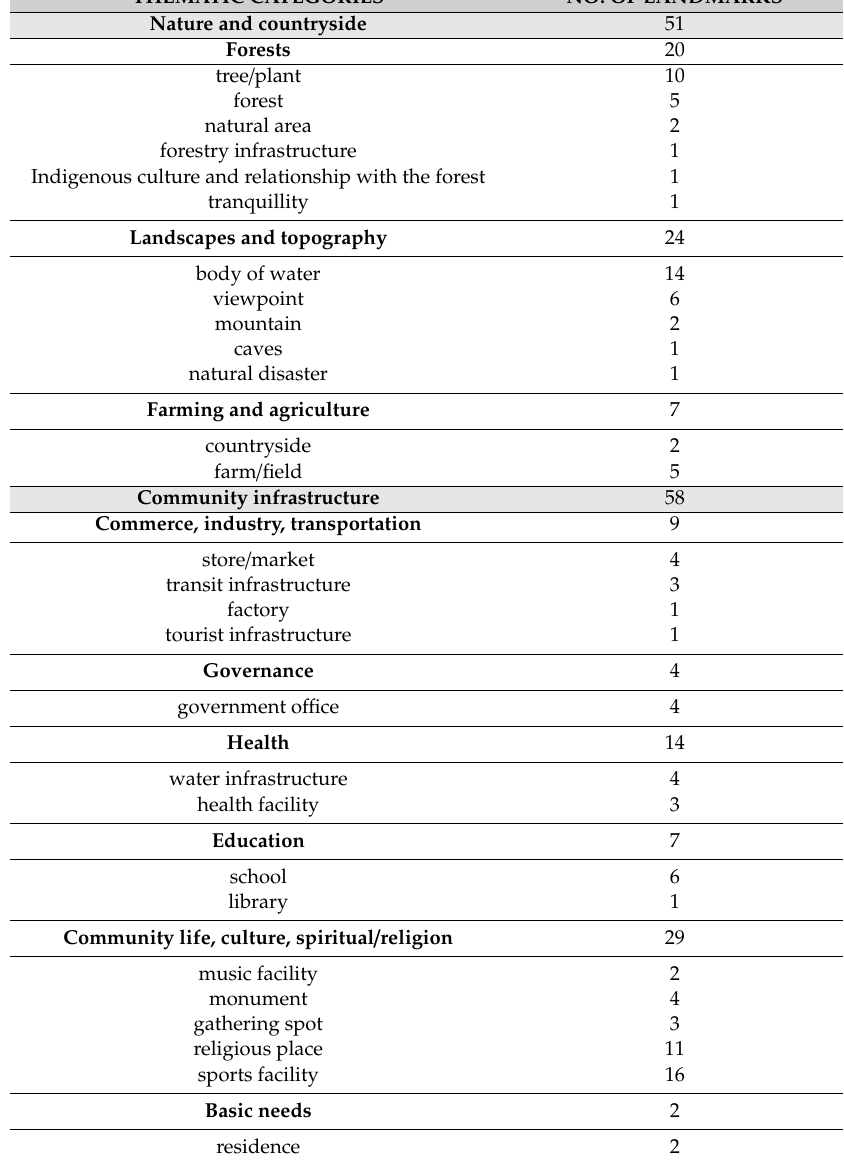
Table 5. Categories of “landmarks” chosen by workshop participants. (aggregate across